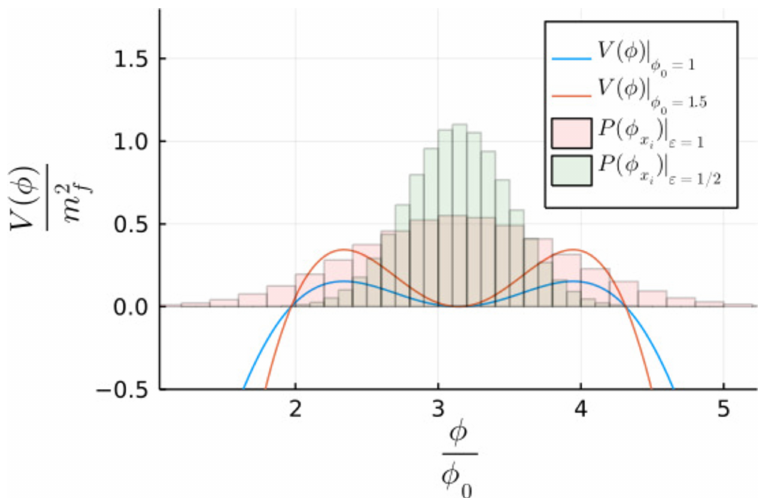
Figure 2 . The potential for φ 0 = 1 and φ 0 = 1 . 5 for am f = 0 . 8 . The superimposed histograms show the initial distribution of φ ( x ) which depends on both the fudge factor (cid:15) and the mass am